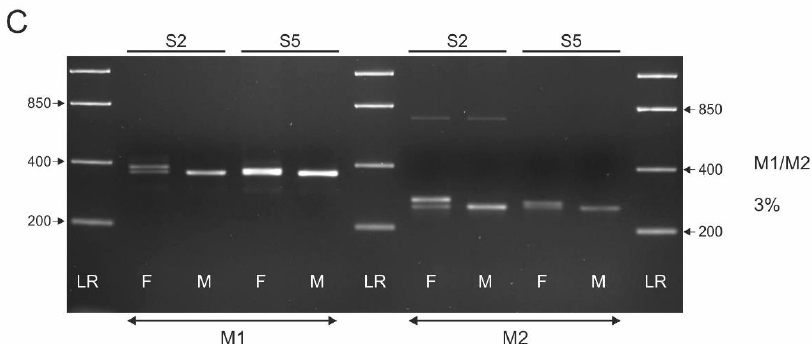
Figure 3. Patterns of the PCR products representing M1 ( A ) and M2 ( B ) markers obtained for male (M) and female (F) individuals of fourteen turaco species (S1 – S14, see Table 1). The amplicons were resolved in 2% agarose gel. The amplicons resolved in 3% agarose gel (S2 and S5) are shown in ( C ). Lane 1 kb — GeneRuler 1 kb DNA Ladder (Thermo Scientific, Waltham, MA, USA). Lane LR — FastRuler Low Range DNA Ladder (Thermo Scientific).